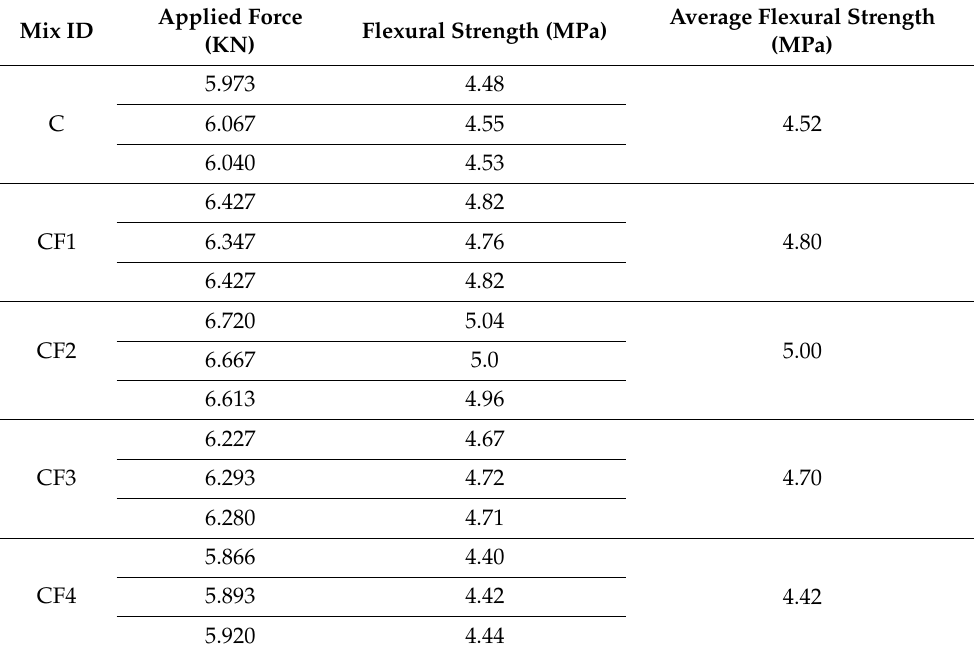
Table 8. Descriptive statistical analysis of concrete subjected to compressive, splitting tensile, and flexural strength.